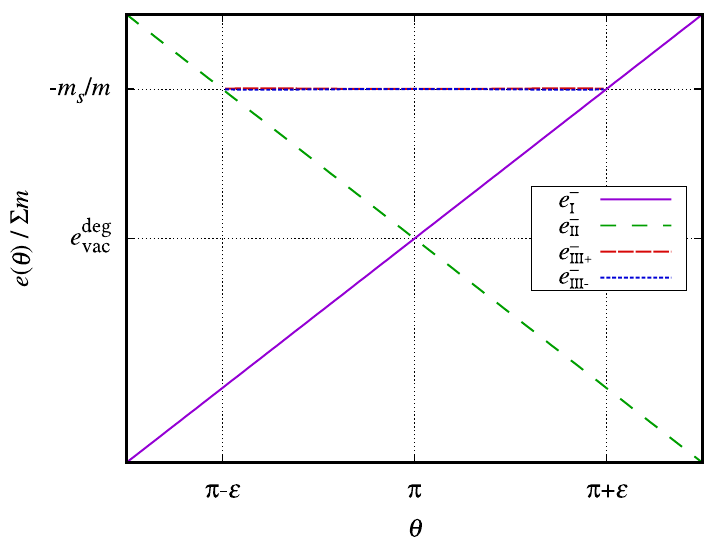
Figure 4 . Stationary points of V (cid:0) ( (cid:18); (cid:11) ) at (cid:18) (cid:24) (cid:25)